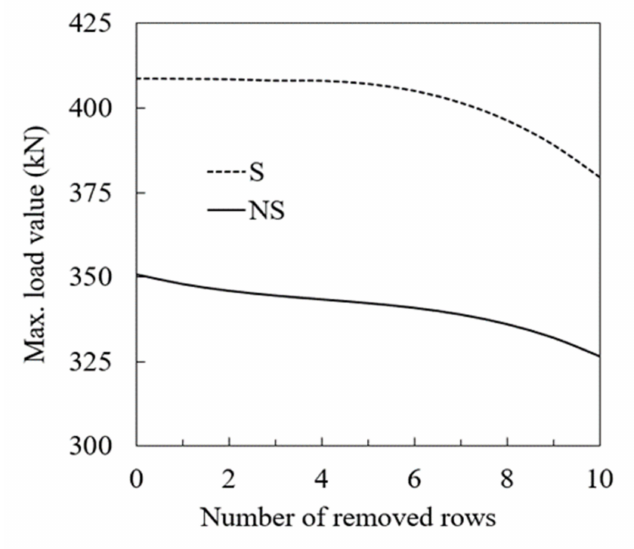
Figure 14. The maximum load-carrying capacity versus the number of removed studs.